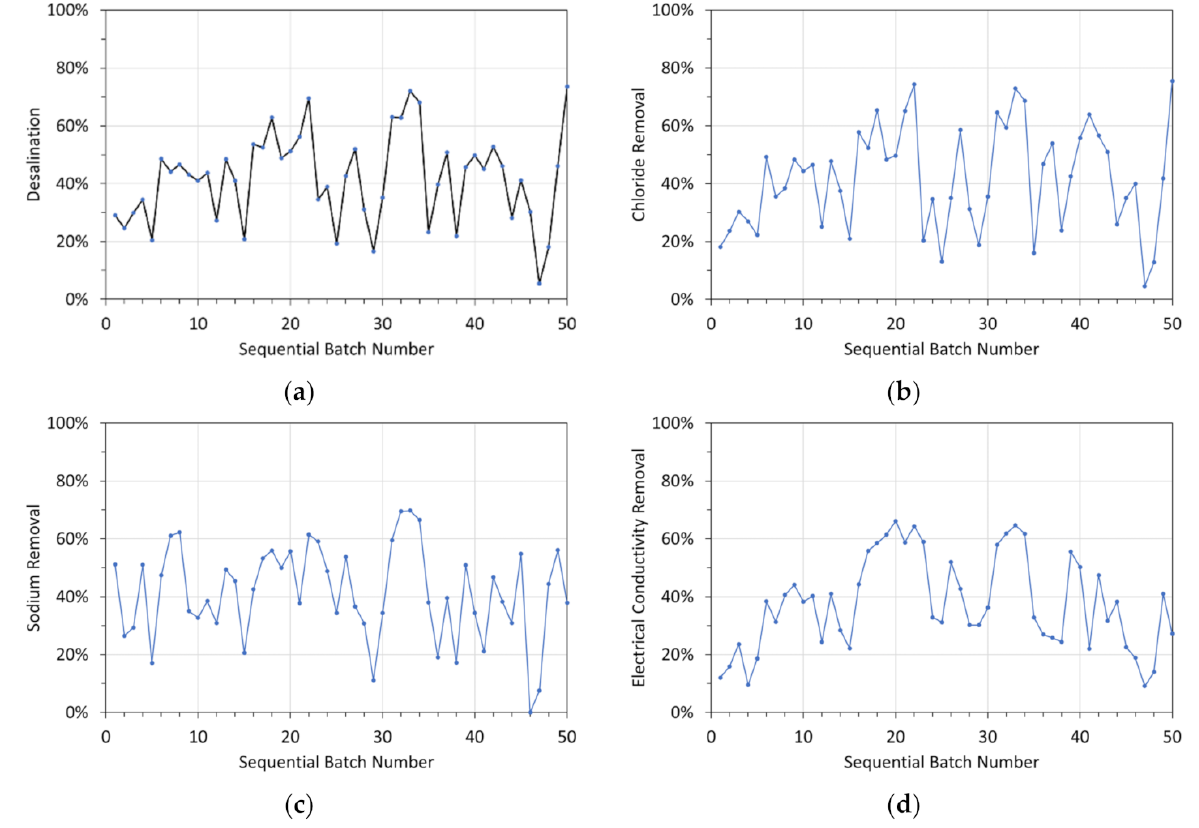
Figure A3. Desalination as a function of sequential batch number. ( a ), Sequential batch number versus desalination; ( b ), Sequential batch number versus chloride removed; ( c ), Sequential batch number versus sodium removed; ( d ), Sequential batch number versus electrical conductivity